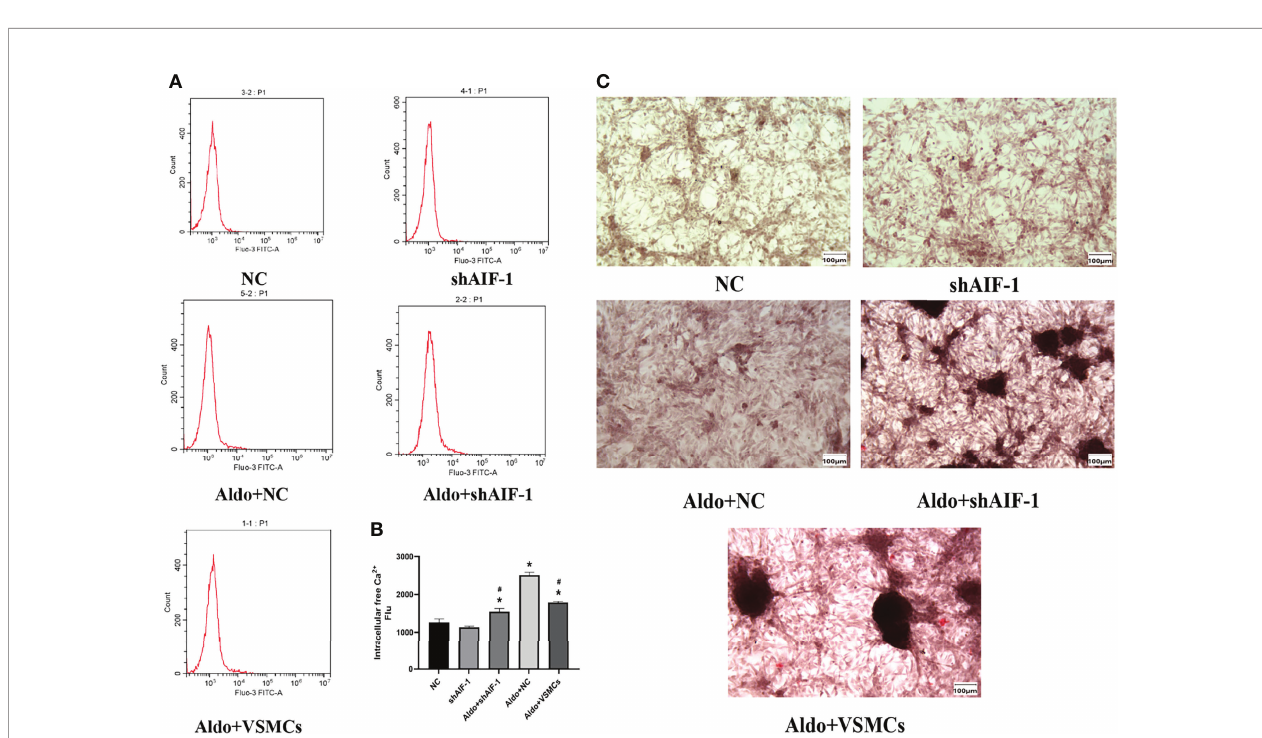
FIGURE 6 | Calcium content using fl ow cytometric (A, B) . The positive area of ALP staining (200X) (C) . (n=6) (*P<0.05, NC group vs. Aldo+ NC groups; # P<0.05, Aldo+NC group vs. Aldo+ shAIF-1